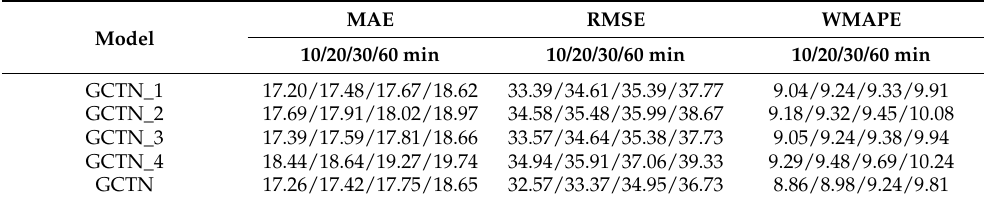
Table 5. Prediction performance of GCTN model and the model with ablation studies. The time interval is 10